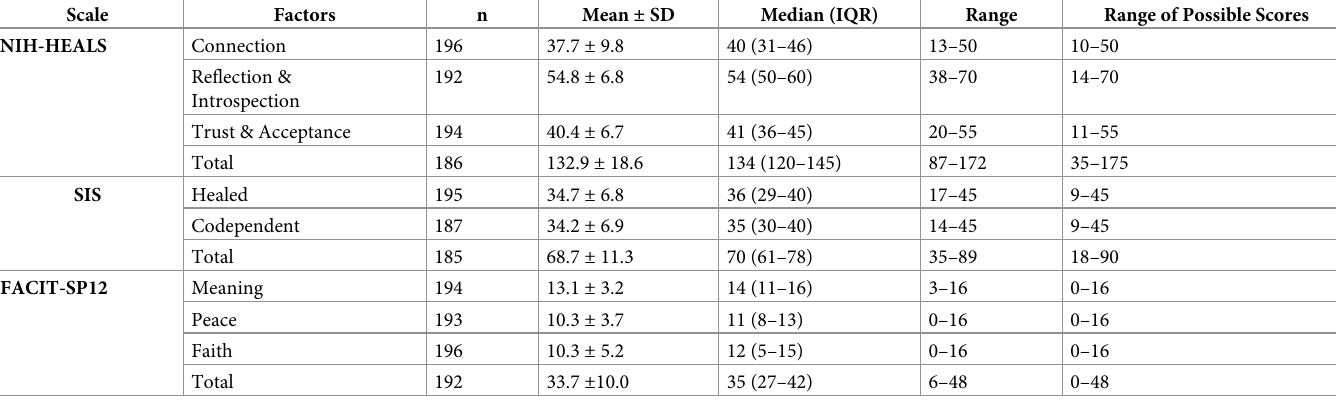
Table 2. Descriptive statistics of scores for the three-factor, 35-item NIH-HEALS measure, SIS, and FACIT-SP12 scale in study participants with serious and life- threatening